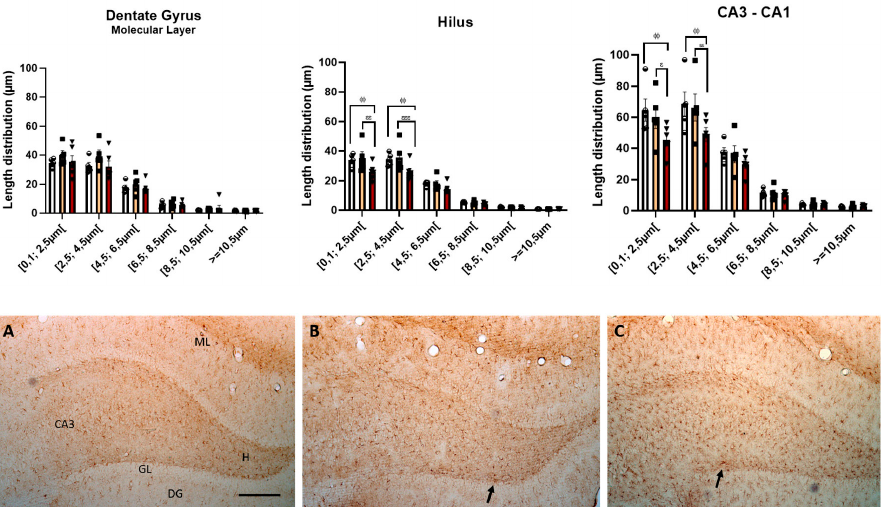
Figure 11. HFHS rats displayed decreased astrocyte processes. The histograms show the mean ± SD length distribution of astrocyte processes in the three different regions of the hippocampus. There was a significant reduction in processes with a minor length distribution compared to the control and HF animals. ϕϕ p < 0.01 HFHS versus controls; ε p < 0.05; εε p < 0.01; εεε p < 0.001 HFHS versus HF animals. The bars in white represent the mean for the control group, the bars in orange represent the mean for the HF group, and the bars in red represent the mean for the HFHS group. The circle represents the value for each animal in the control group, the square represents the value for each animal in the HF group, and the inverted triangle represents the value for each animal in the HFHS group. Representative photomicrographs of level-matched coronal sections of the hippocampus formation from control ( A ), HF ( B ), and HFHS ( C ) rats immunostained for Glial Fibrillary Acidic Protein (GFAP). Arrows show GFAP-immunopositive cells in the hippocampus formation. ML, dentate gyrus molecular layer; GL, granule cell layer; H, dentate hilus; DG, dentate gyrus; CA3, pyramidal cell layer of CA3 hippocampal field. Scale bar = 100 µm.